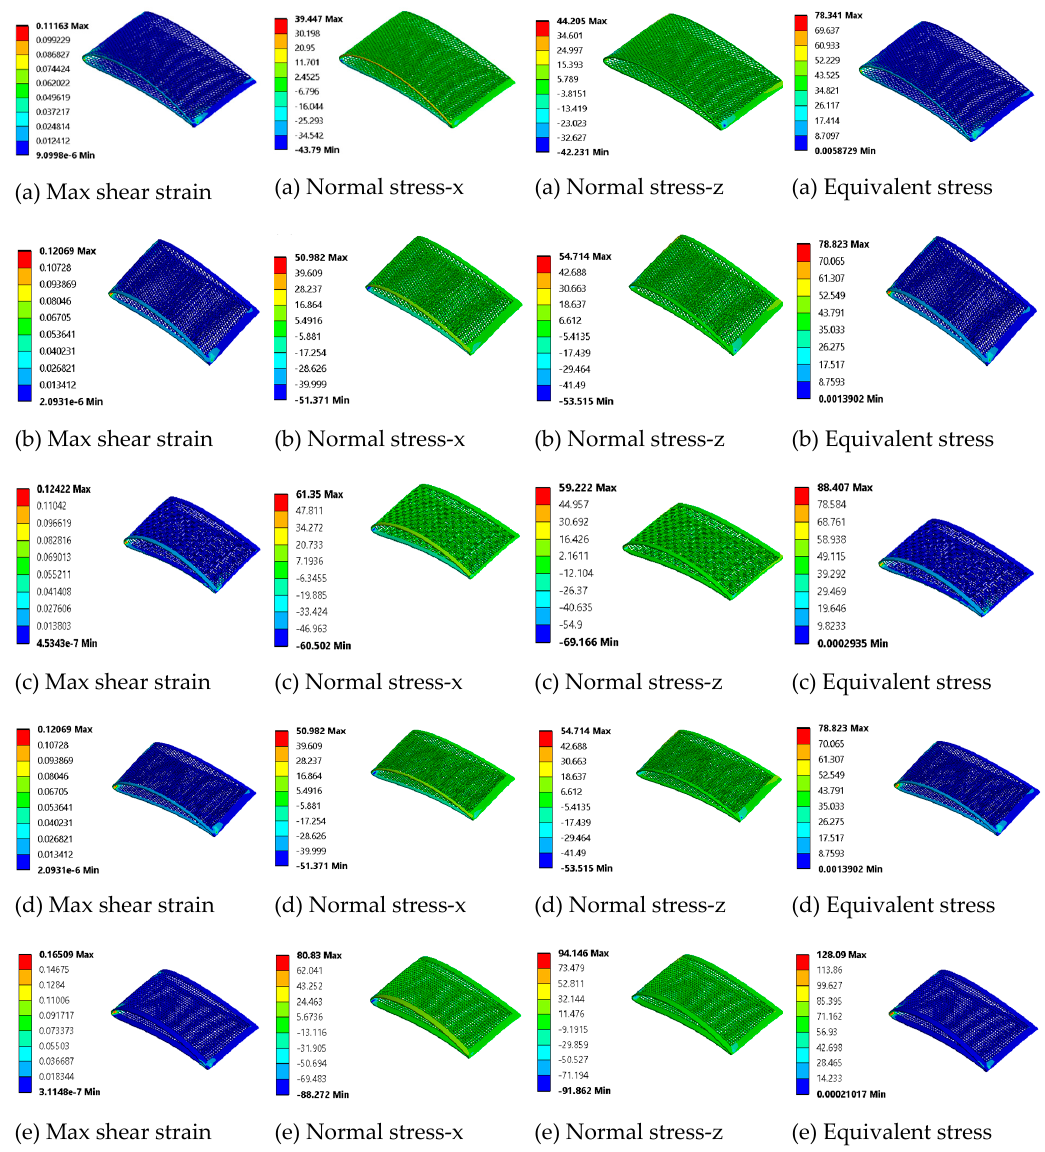
Figure 12. Some of the material properties for selected models: ( a ) honeycomb, ( b ) auxetic, ( c ) chiral, ( d ) zero Poisson’s ratio honeycomb, and ( e ) square lattices in x, y, and z axes respectively